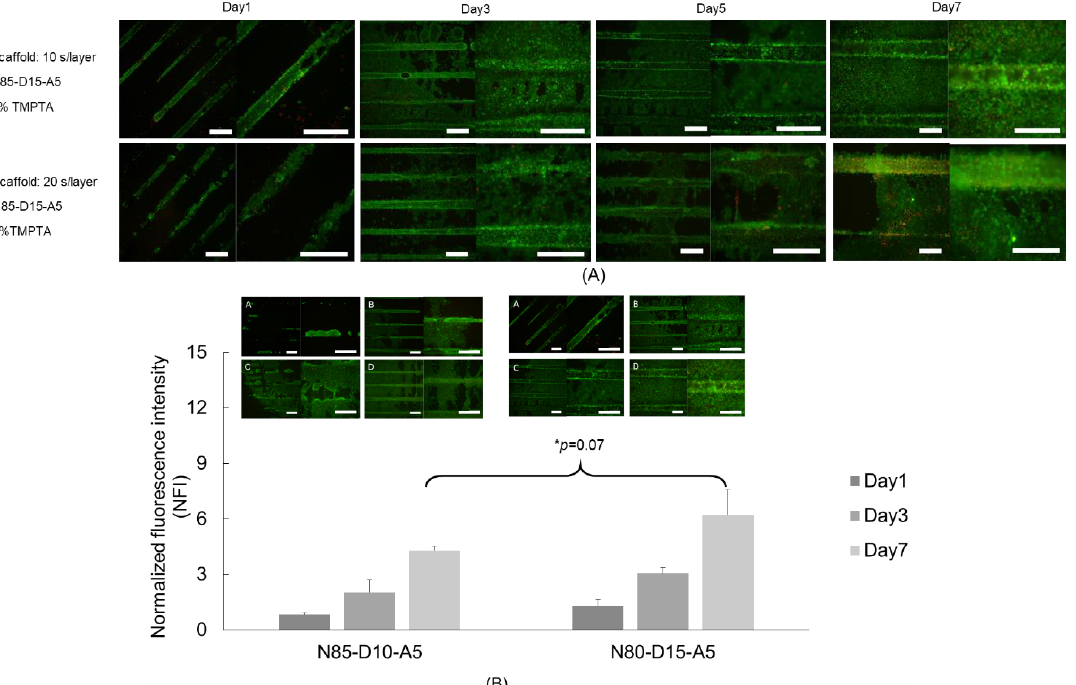
Figure 6. ( A ) Cellularity (L9292 fibroblasts) on GF-based scaffolds with raft architecture (N80-D15-